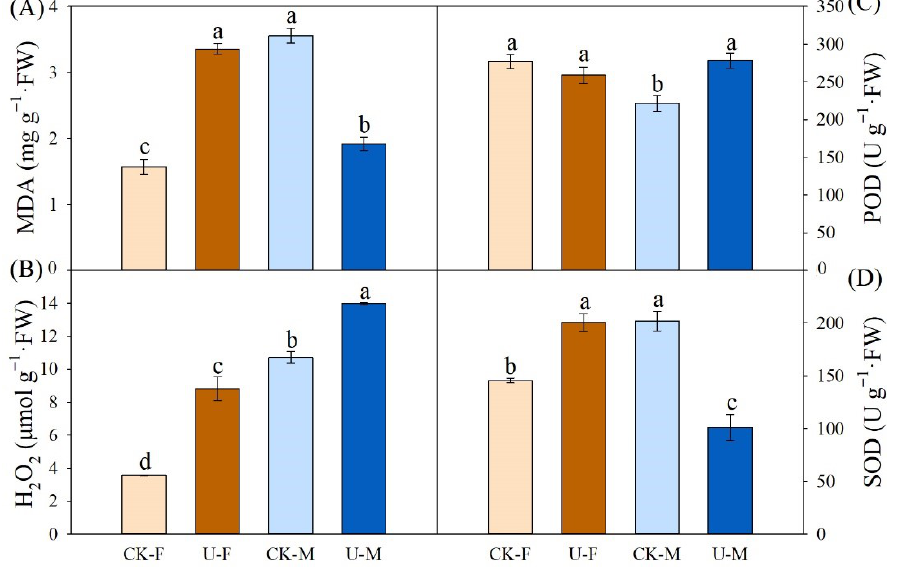
Figure 5. Female and male trees of P. cathayana : MDA ( A ), H 2 O 2 ( B ), and the activity of antioxidant enzymes POD and SOD ( C , D ). Values are expressed as means ± SE ( n = 3). Different letters represent significant differences between treatments ( p <